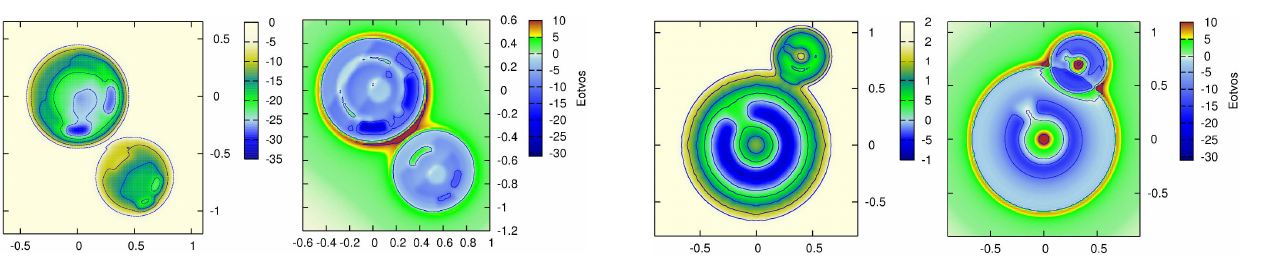
Fig. 13. (a)–(b) Gravity anomalies (left) and the second radial derivatives, T rr (right), of Chicxulub and its hypothetic companion (in mGal and E, respectively) as derived from the craters model. For EGM2008 see Figs. 4 and